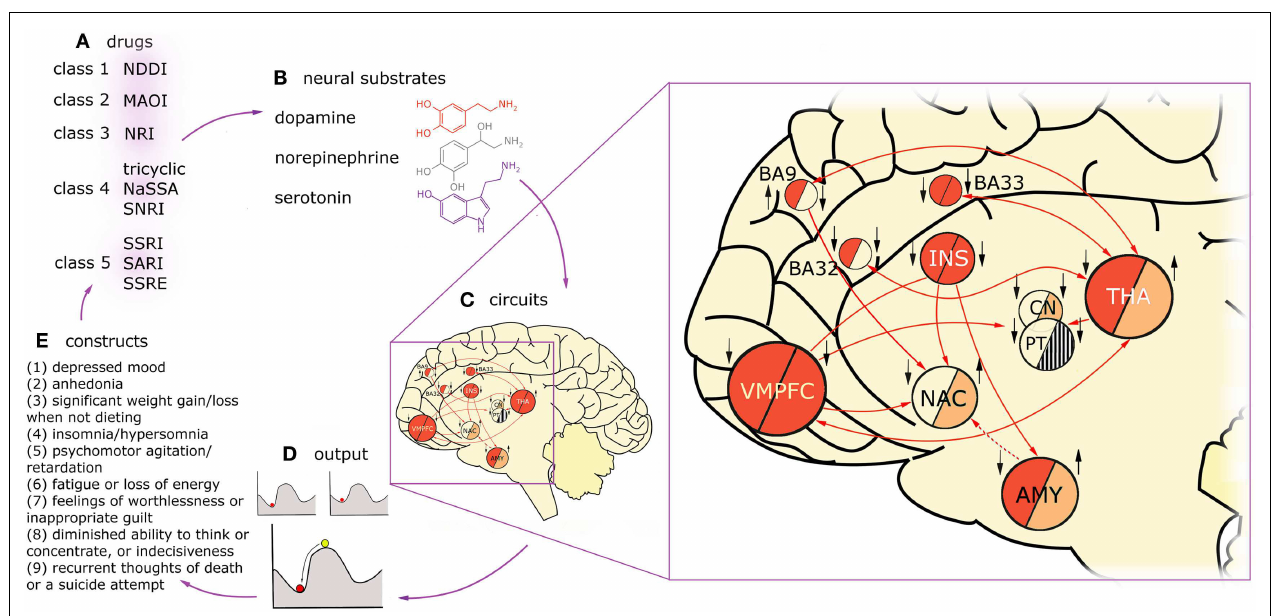
FIGURE 1 | Diagnosis, treatment, and brain dynamics in MDD . One can distinguish five classes of drugs (A) on the basis of monoamine receptors that they target (B) . Functional MRI studies reveal that these drugs affect different, but overlapping circuits (C) . Here, two exemplary circuits are presented on the basis of imaging studies on two constructs present in MDD: low mood (or negative affect) and anhedonia (lack of positive affect). The connectivity in the circuits is presented with arrows, solid lines for glutamatergic, and dashed lines for GABAergic projections. Findings on regions activated in negative affect in depressed patients are summarized in the “negative affect” circuit, left half-circles.The subjects were triggered to fall into low mood by presenting them with scenes of negative emotional valence. Findings on regions up- and down-regulated in anhedonic MDD patients during presentation of scenes with positive emotional valence are summarized in the “anhedonia” circuit, right half-circles. Deep red color depicts overactivation in a given region during the task in respect to healthy controls, light red – hypoactivation, stripes – counteracting evidence in the literature, background color – no data. Additionally, treatment effects of fluoxetine in the nodes of this network are indicated with black arrows (up: